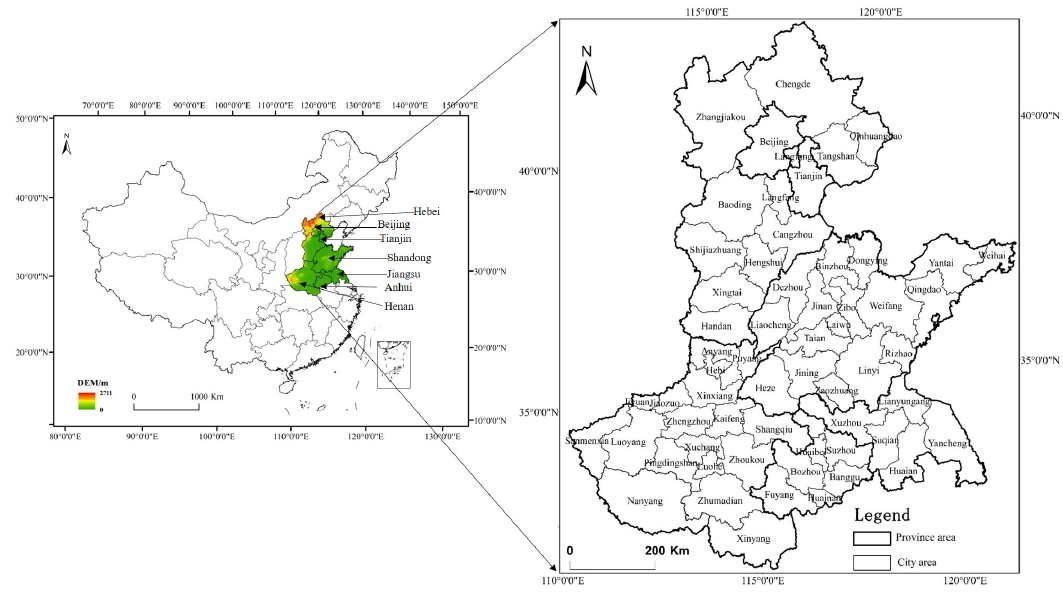
Figure 1. Location map of the Huang-Huai-Hai Plain (HHH) .